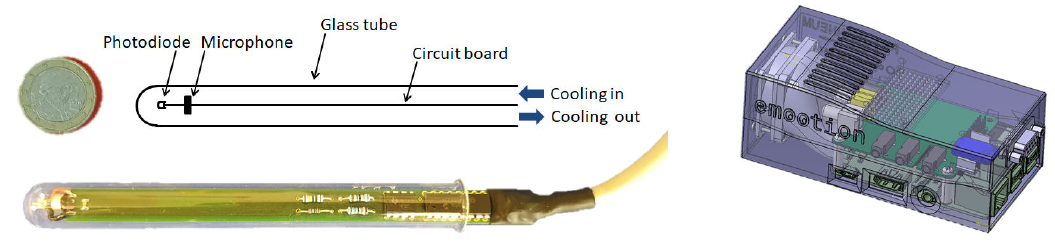
Figure 4. The TRL 2 RCP hardware, with the probe ( left ) and it autonomous microcontroller ( right )